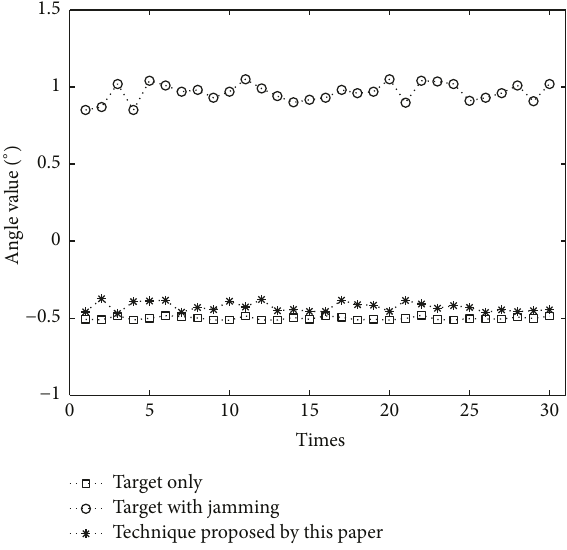
Figure 5: Angle estimation of the target being interfered with by the corner